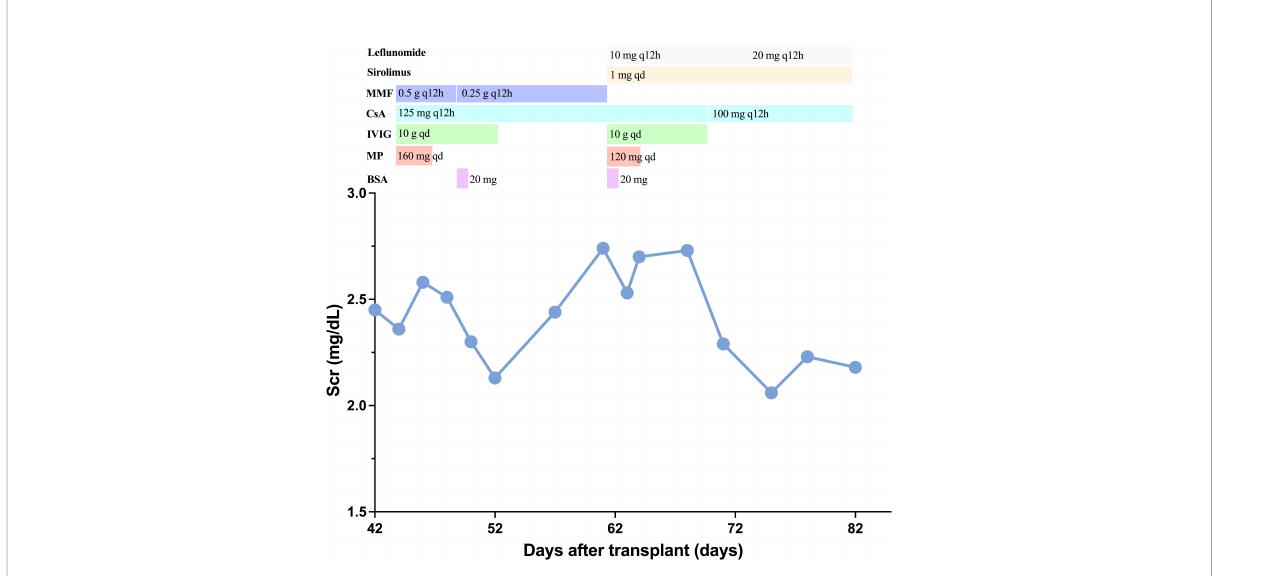
FIGURE 2 Clinical course. Change of serum creatinine and immunosuppressive agents treatment. BAS, basiliximab; MP, methyl prednisolone; IVIG, intravenous immunoglobulin; CsA, cyclosporin; MMF, mycophenolate mofetil.